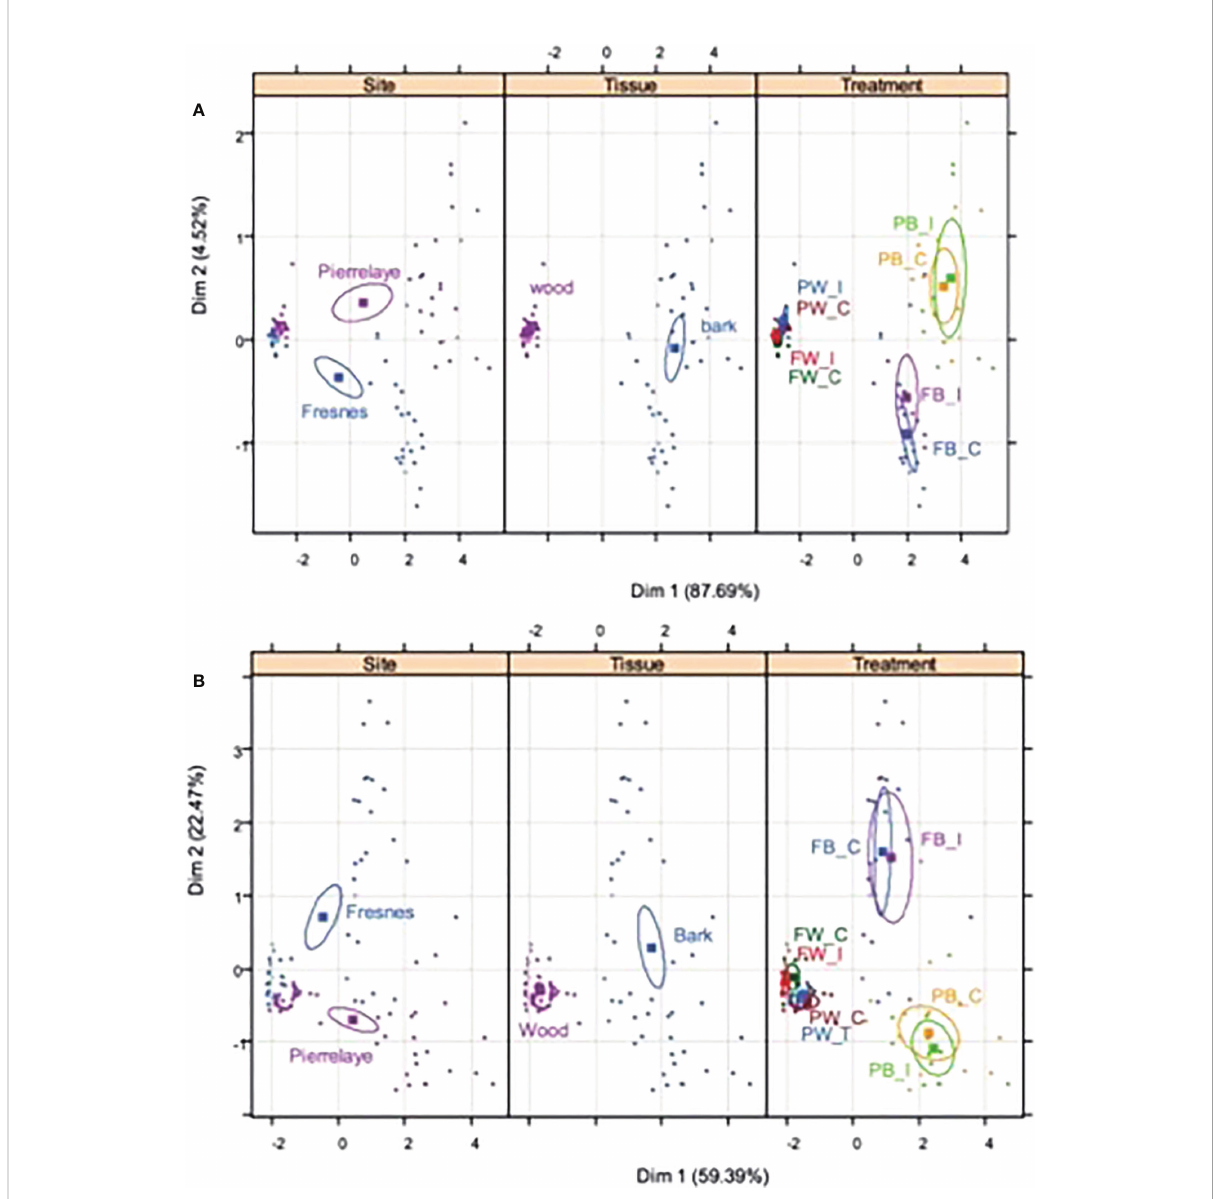
FIGURE 1 Principal component analysis showing the correlations of the nutrients (A) and potential toxic elements (B) for the two study soils (Fresnes-sur- Escaut and Pierrelaye), in two different plant tissues (wood and bark) and for the two treatments (control, C; inoculated, I). Results of the Monte Carlo permutation test demonstrate the different distributions of the nutrients and potential toxic elements (P =